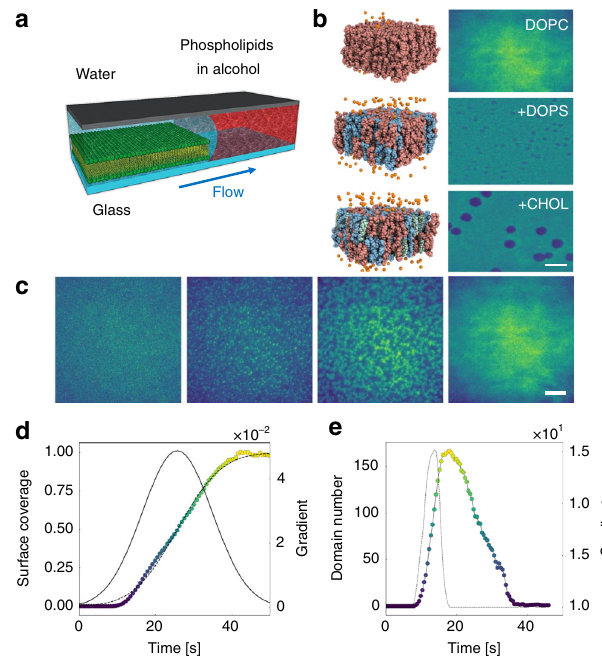
Fig. 1 Supported lipid bilayer deposition by solvent exchange in a micro fl uidic channel. a Schematic of the solvent exchange process to produce single lipid bilayer on a hydrophilic substrate. b Molecular models and the corresponding TIRF results of single lipid bilayers with different components: DOPC, 40:100 DOPS:DOPC and 40:30:100 DOPS:CHOL: DOPC. Scale bar: 10 μ m c Representative images of lipid bilayer formation on glass substrate, illustrating a nucleation and growth process. Scale bar: 10 μ m. d Plot of surface coverage of DOPC versus time. The data, error function best fi t and best fi t gradient are shown as the coloured circles, dashed line and solid line, respectively. e Plot of number of DOPC domains versus time and its gradient as a function of time, shown as coloured circles and the dashed line,